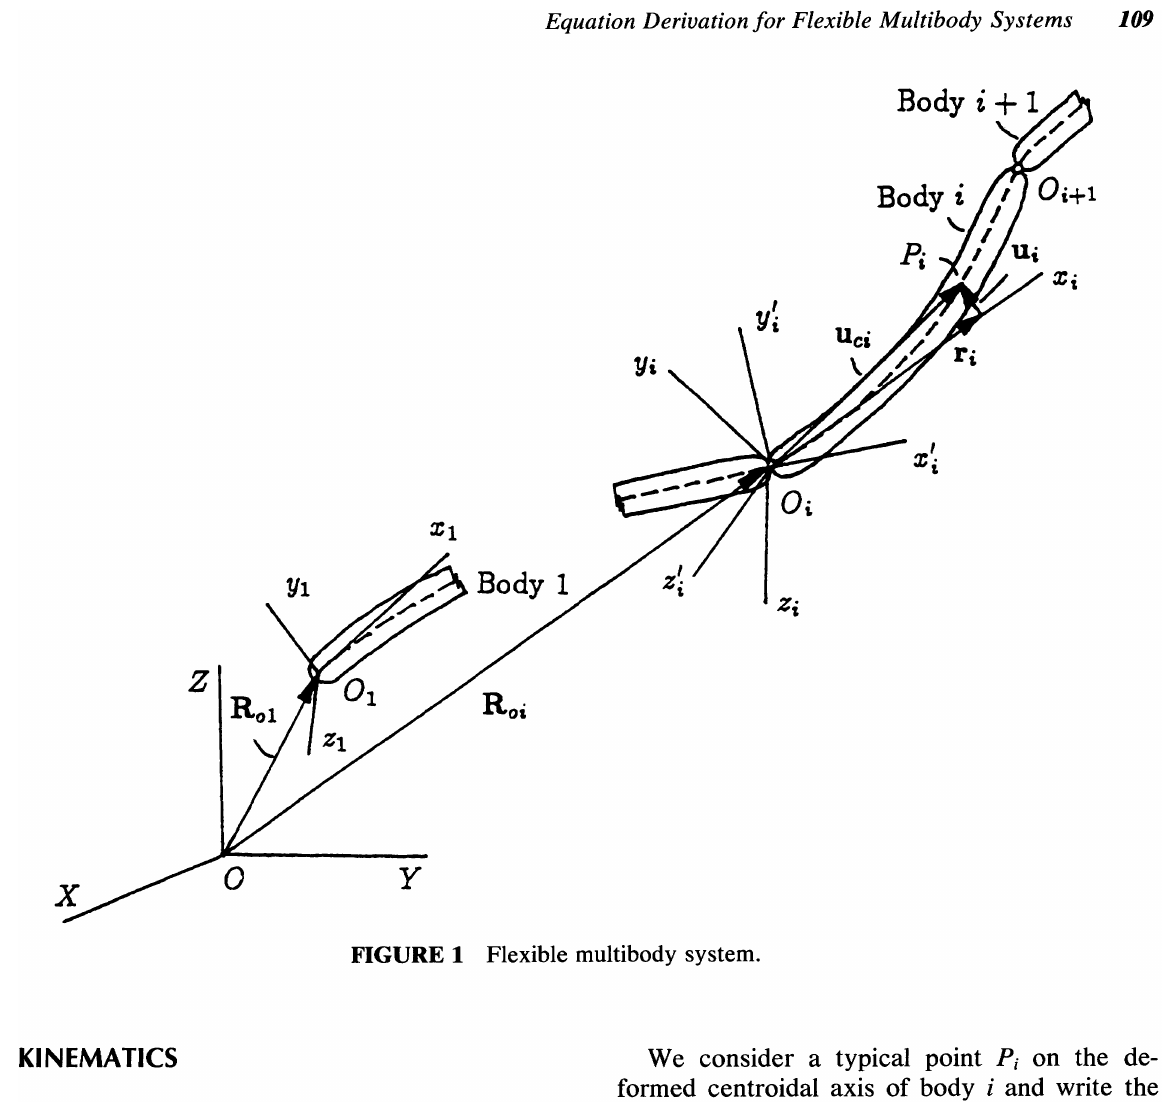
FIGURE 1 Flexible multibody